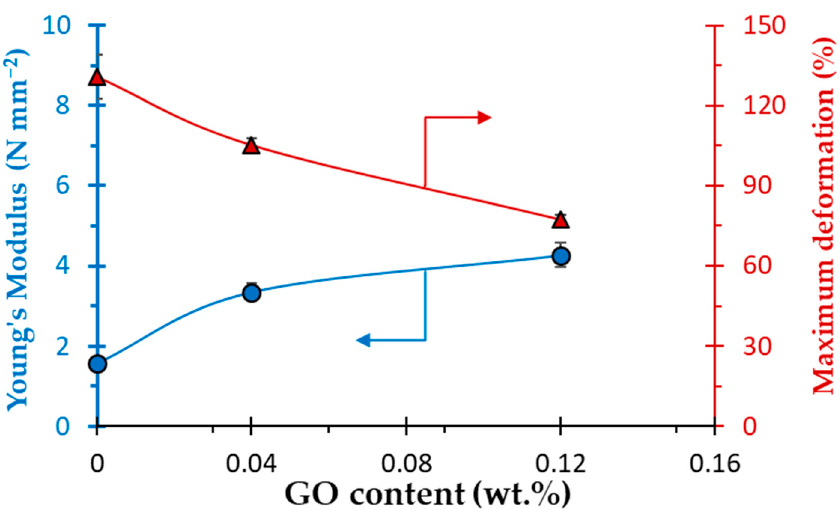
Figure 5. Young’s Modulus (blue circle) and maximum deformation (red triangle) as a function of the GO content in the bituminous membranes. Error bars’ dimension is smaller than or close to the dimension of the symbols.